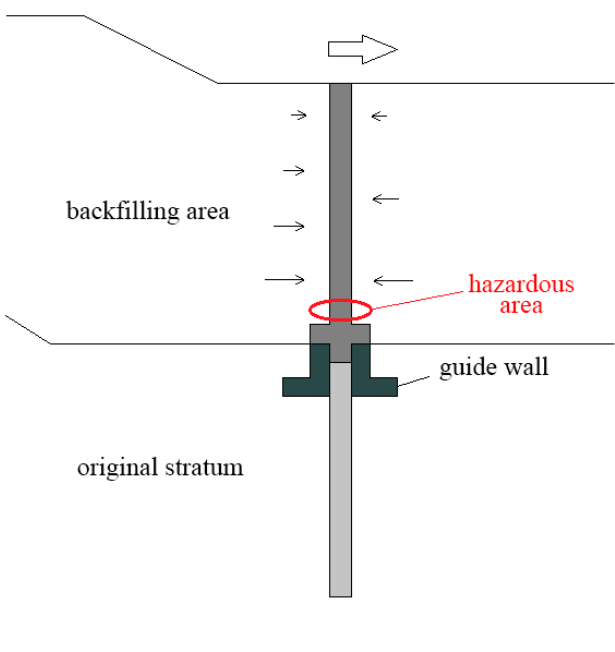
Figure 14. Schematic diagram of maximum stress area of cut-off wall.